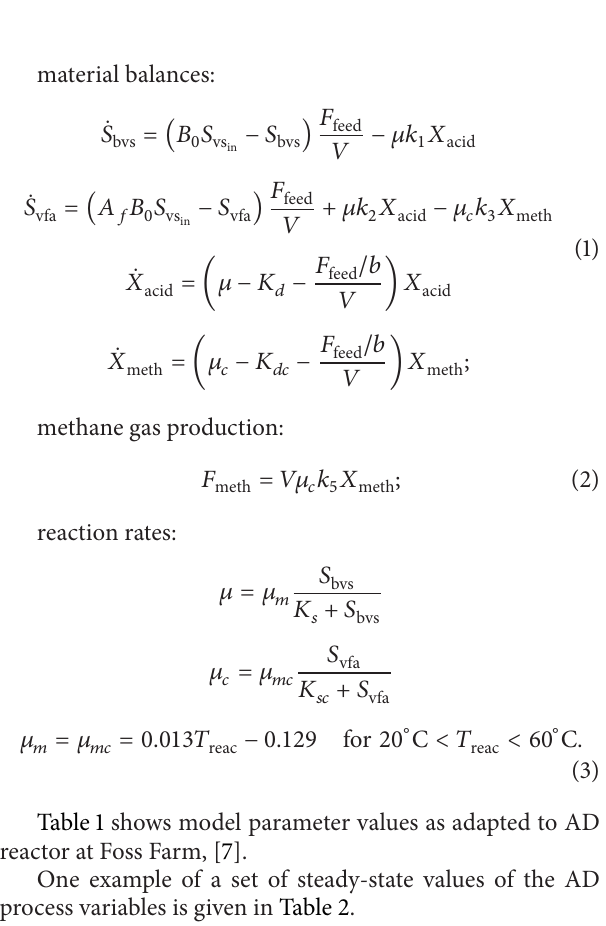
Figure 2: Block diagram of model-based optimization and control system. (Terms and variables are defined in the text.)